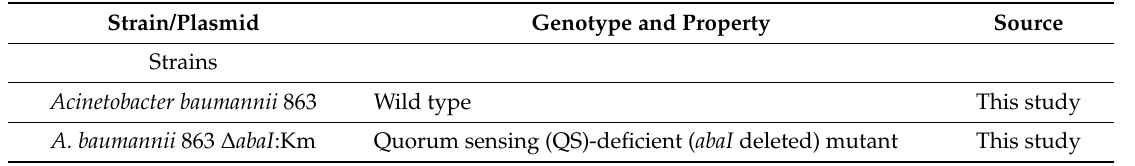
Table 1. Bacteria strains and plasmids used in this